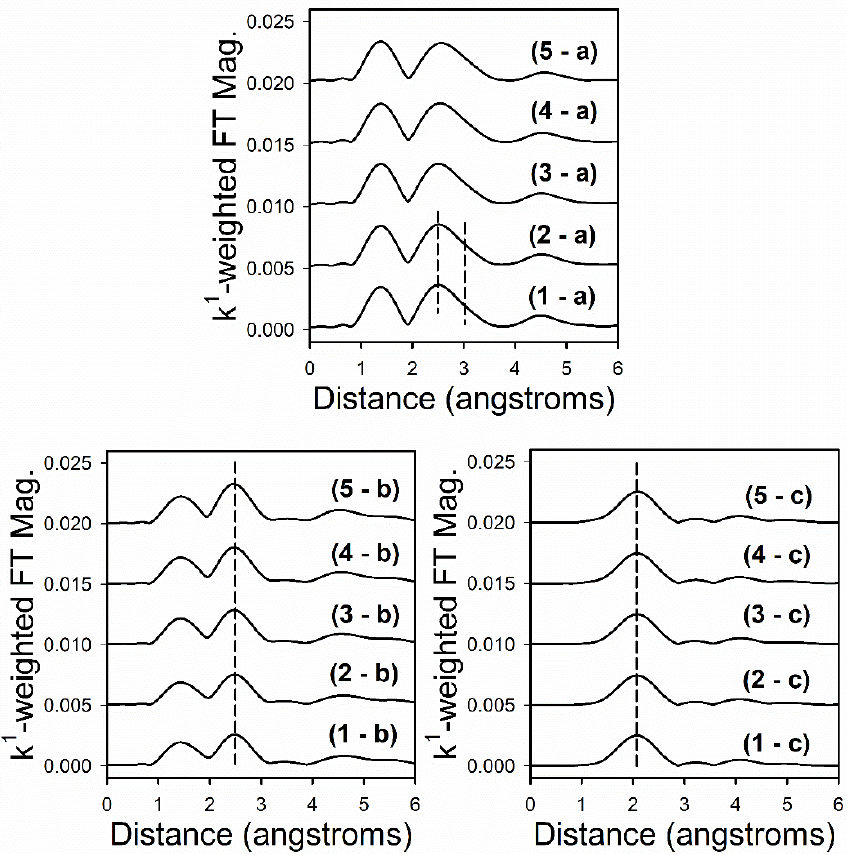
Figure 10. Co K-edge EXAFS spectra of ( a ) the initial point consisting of primarily Co 3 O 4 , ( b ) the point of maximum CoO content, and ( c ) the final spectrum consisting of primarily Co 0 for ( 1 ) 25%Co / Al 2 O 3 , ( 2 ) 25%M (M = 5%Ni-95%Co) / Al 2 O 3 , ( 3 ) 25%M (M = 10%Ni-90%Co) / Al 2 O 3 , ( 4 ) 25%M (M = 25%Ni-75%Co) / Al 2 O 3 , ( 5 ) 25%M (M = 50%Ni-50%Co) / Al 2 O 3 .